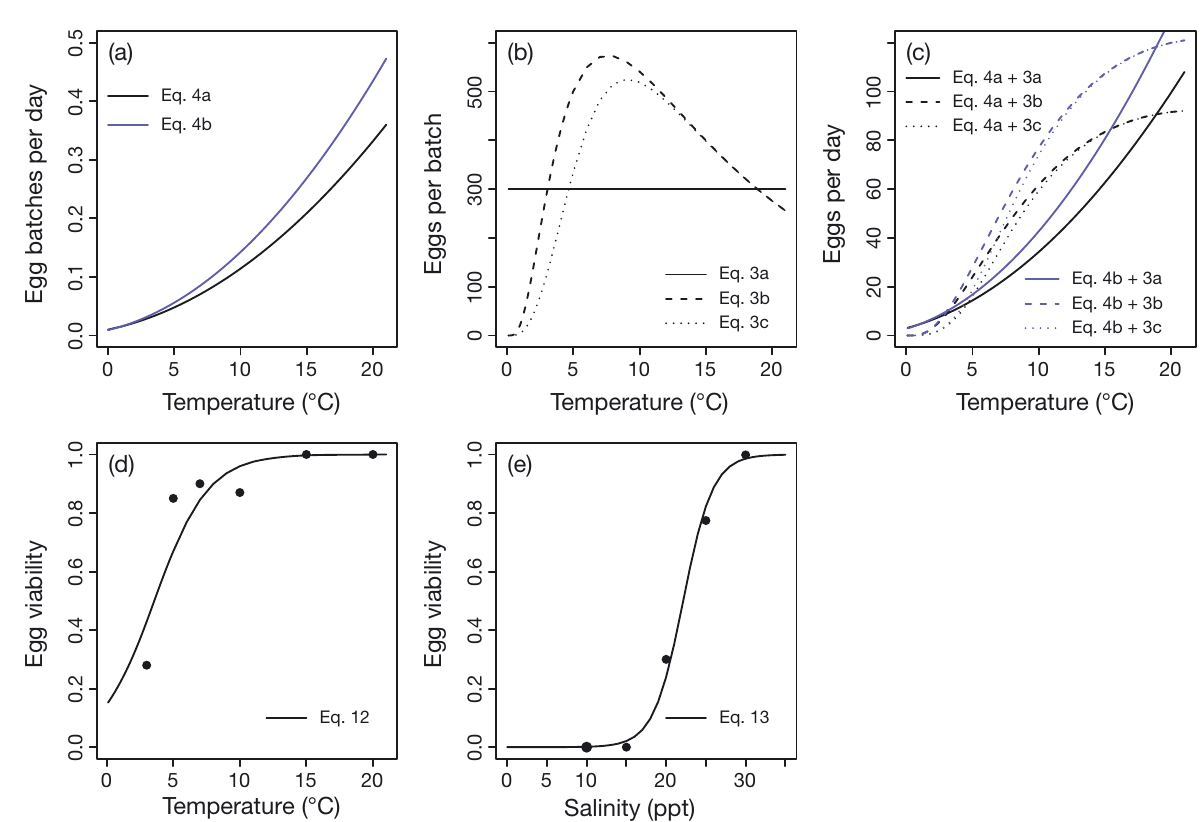
Fig. 4. Alternative egg production functions for salmon lice. (a) Number of egg batches released by each female per day. This function is the inverse of the egg development times shown in Fig. 3a (Eqs. 4a & 4b). (b) Number of eggs per egg batch at dif- ferent temperatures, assuming constant egg batch size (Eq. 3a), temperature-dependent egg batch size (Samsing et al. 2016, Eq. 3b), or temperature-dependent egg batch size and temperature-dependent egg viability (Eqs. 12 & 3c). (c) Number of eggs released by each female per day for different functions for egg batches per day and eggs per batch. (d) Temperature effect on egg viability (logistic regression line fitted to data from Samsing et al. 2016). (e) Salinity effect on egg viability (logistic